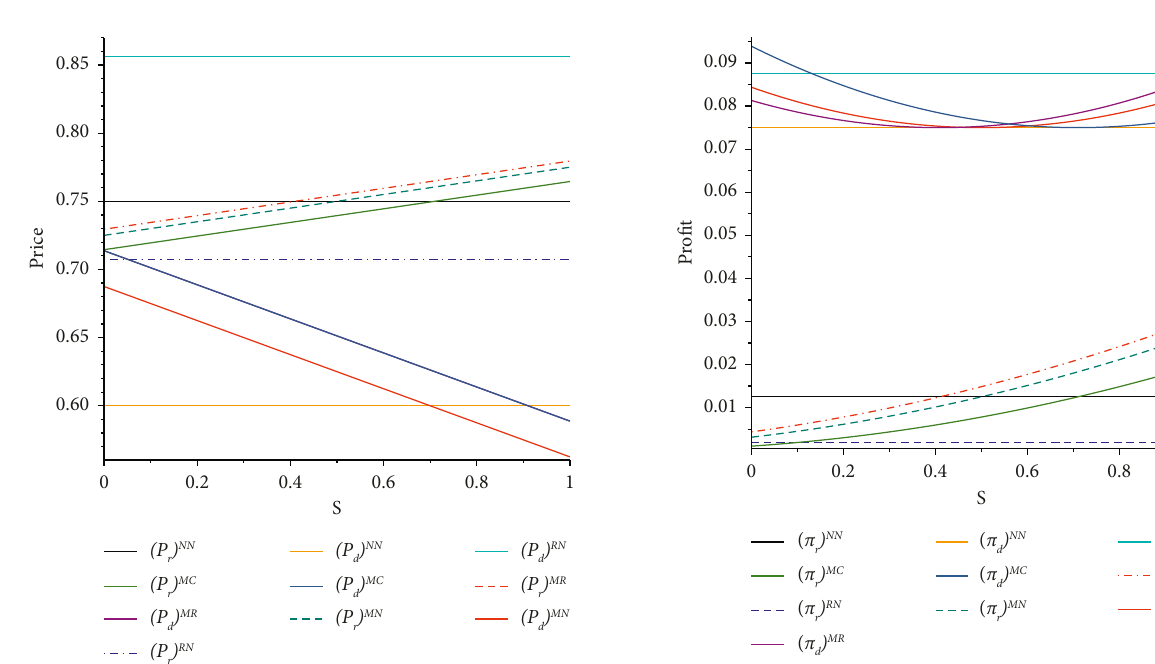
Figure 3: Effect of s on optimal price. Figure 4: Effect of s on optimal